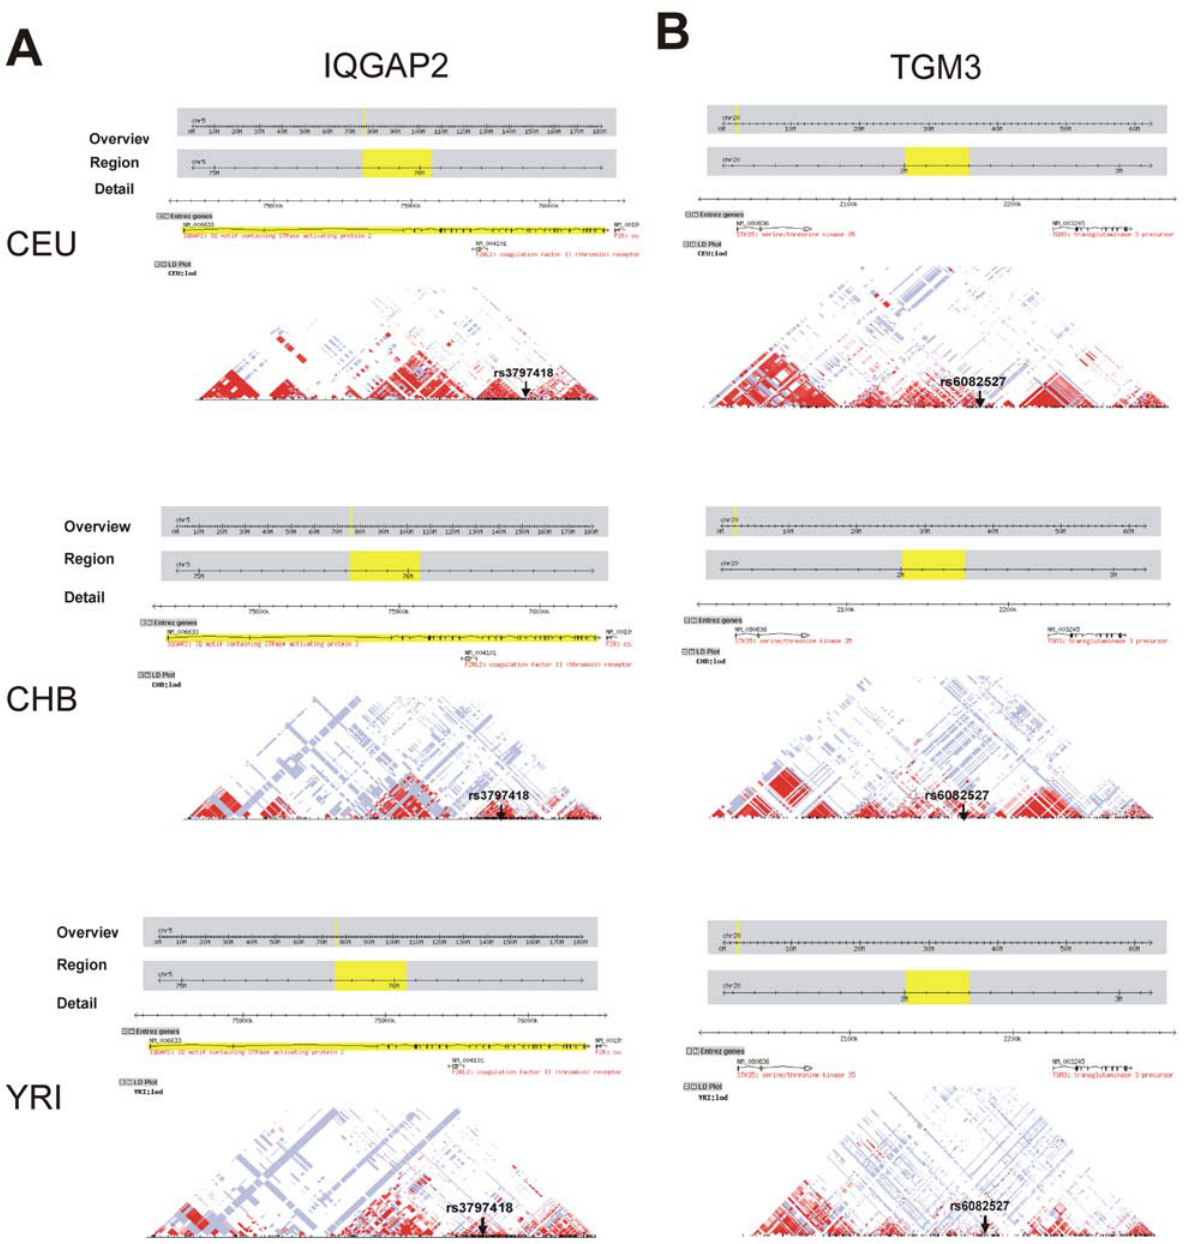
Figure6.Linkagedisequilibrium within , 300 Kbsurroundingthe rs3797418 and rs6082527 SNPs. Red indicates combinations where D 9 =1 and linkage of disequilibrium (LOD) $ 2; light red, combinations where D 9, 1 and LOD $ 2; red squares, combinations where D 9 =1 and LOD , 2; white squares, combinations with D 9, 1 and LOD , 2. SNPs are arranged in order from 5 9 to 3 9 in each gene, as shown in the gene structure above each plot. doi:10.1371/journal.pone.0007765.g006 The lymphoblastoid cell lines were transfected with control siRNA and specific siRNA for GPM6A and VAV3 using the electropo- ration (Nucleofector H Lonza Walkersville Inc., Walkersville, MD). Specifically, 1.25 6 10 6 cells suspended in Cell Line Nucleofector Solution V (Lonza Walkersville Inc.) were mixed with 2 m M control or specific siRNA before the electroporation.